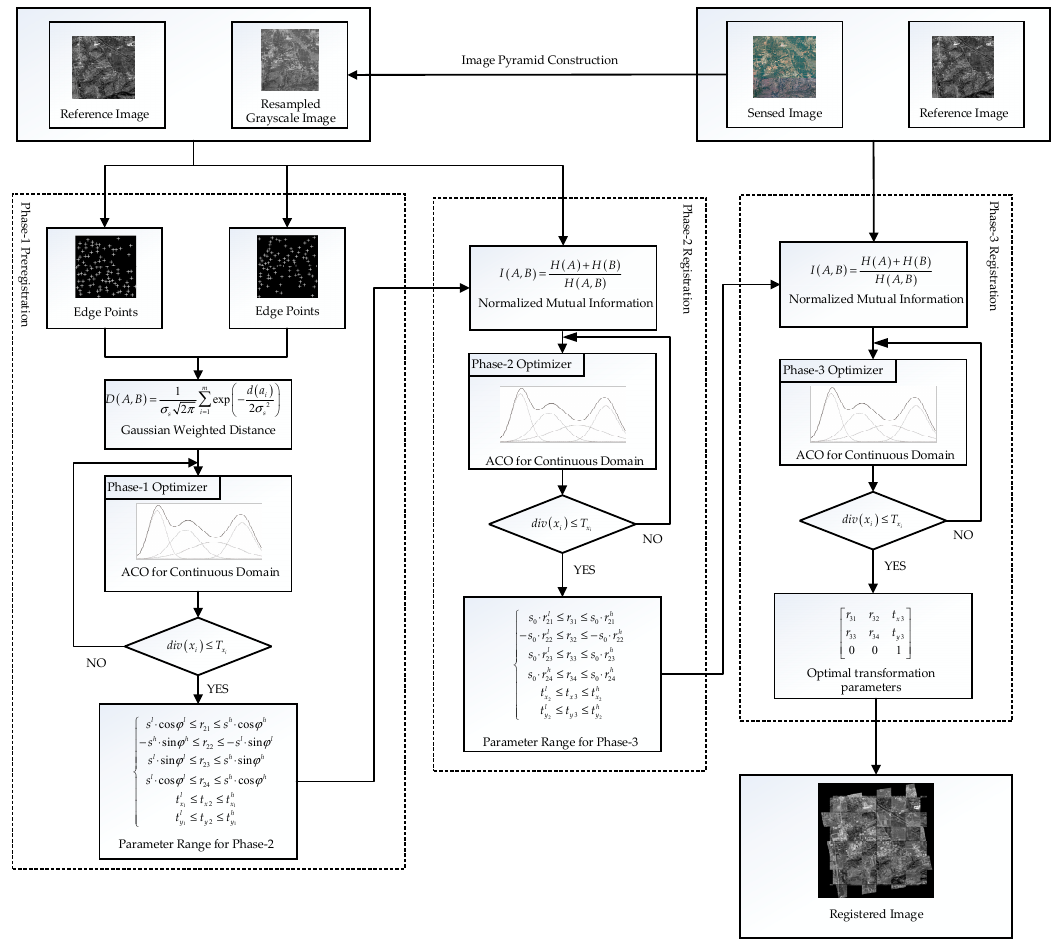
Figure 1. Flowchart of the proposed method. ACO: ant colony optimization.